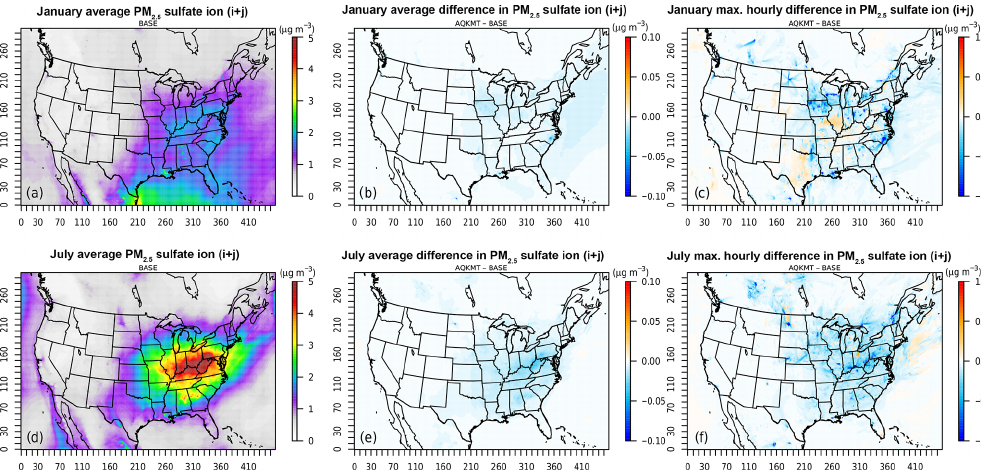
Figure 3. Average baseline (a, d) and average (b, e) and maximum (c, f) hourly difference (AQKMT − Base) in fine SO 2 − January and July 2011 using CMAQv5.1. Note the different scales for average baseline concentration, average difference, and maximum difference plots.